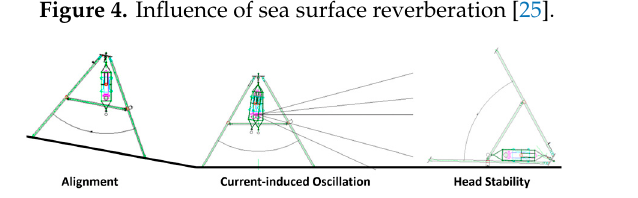
Figure 4. Influence of sea surface reverberation [25].